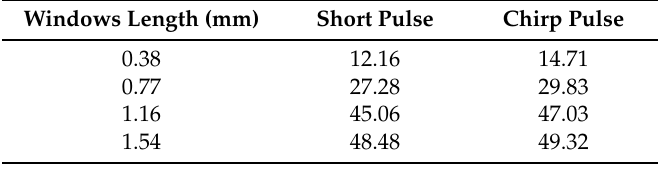
Table 2. Elastographic contrast-to-noise ratio (CNRe) measured for lesion phantom on Figure 23.